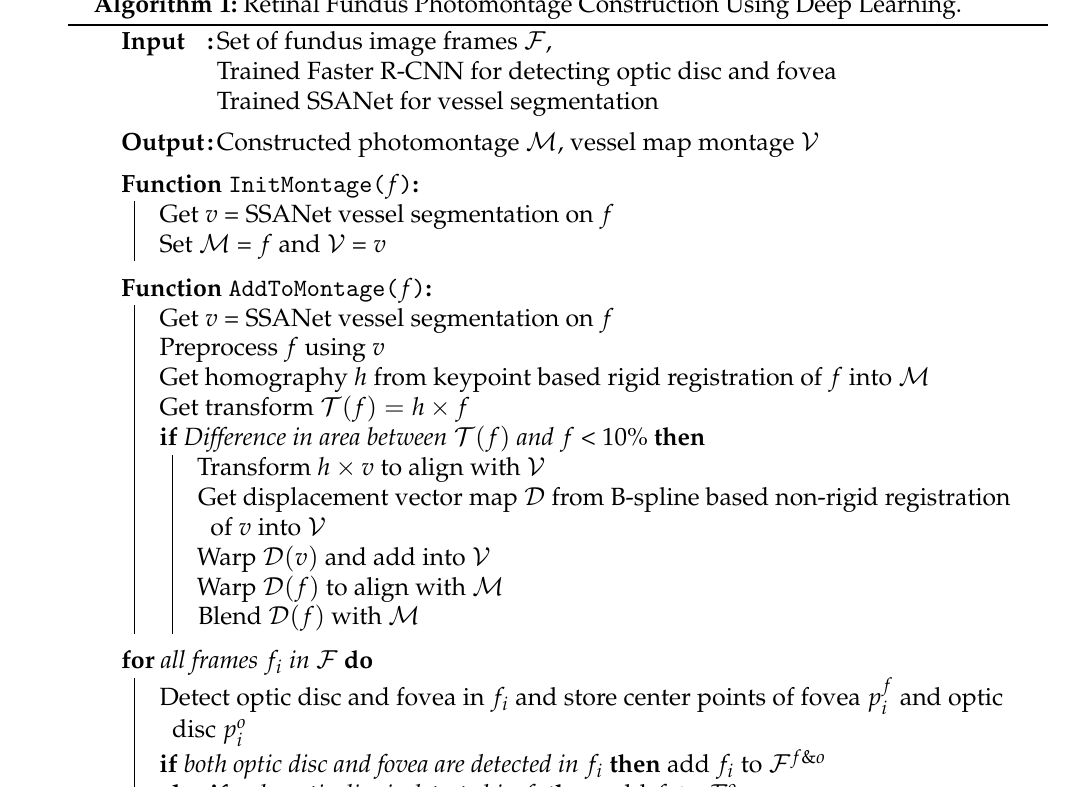
Algorithm 1: Retinal Fundus Photomontage Construction Using Deep